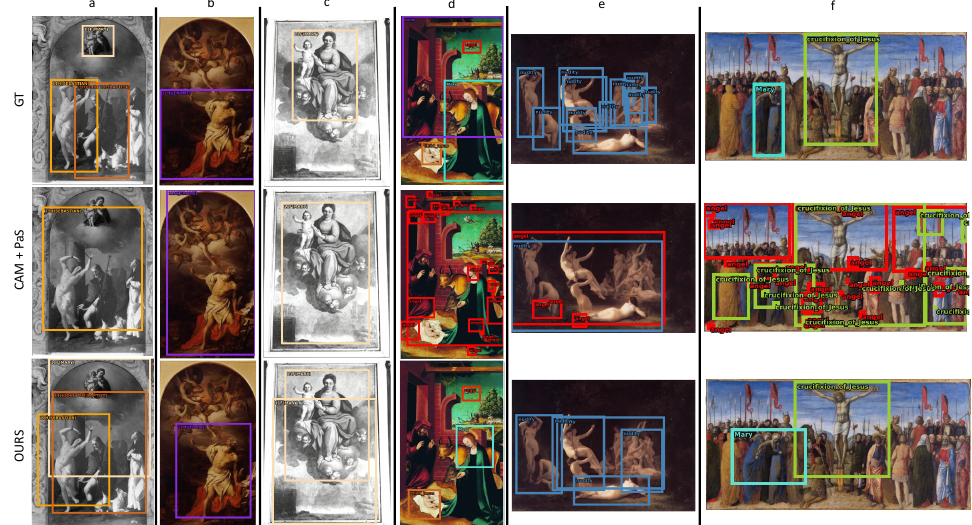
Figure 4. Positive WSOD detections —This figure presents positive examples on ( a – f ) six artworks from the ArtDL 2.0 and IconArt data sets. The first row contains the manually annotated ground truth, the middle row presents bounding boxes generated from CAM + PaS and the third row shows detections from the proposed WSOD method. Bounding boxes are color-coded by class for better